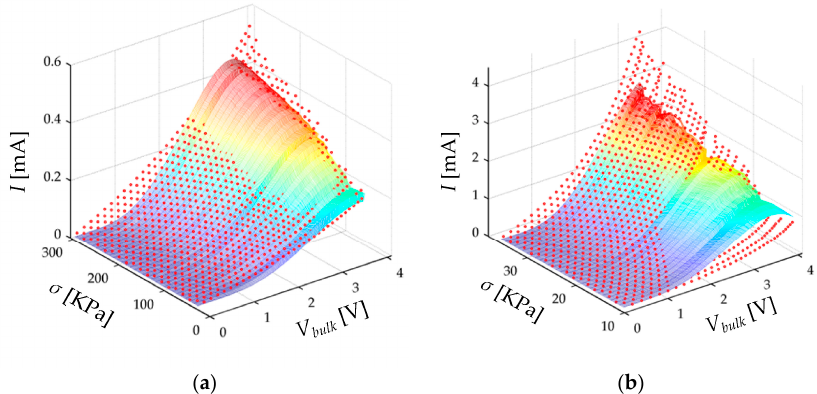
Figure 15. Surface fit and experimental data for the piecewise Equations (39)–(41). Plots for the sensors: ( a ) FlexiForce A201-1 and ( b ) Interlink FSR 402.